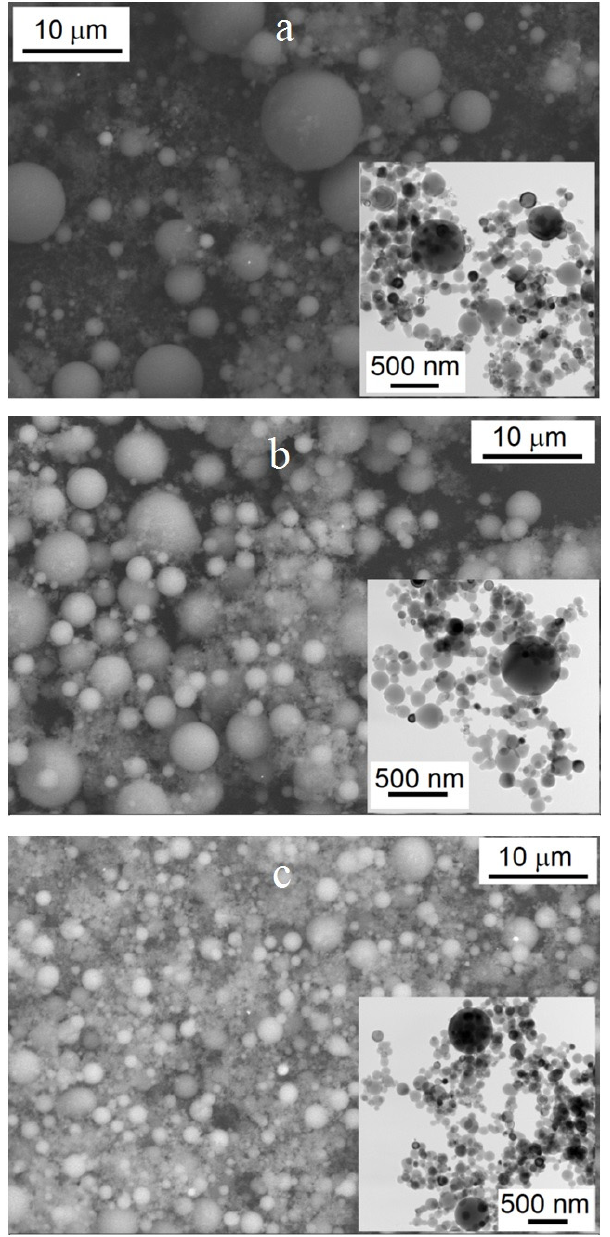
Figure 4. SEM images of aluminum particles. Inset shows TEM images of aluminum nanoparticles and submicroparticles: ( a ) Sample 1, ( b ) Sample 2, ( c ) Sample 3. With an increase in energy input to E/Es = 0.63 (Sample 2), the proportion of submi- cron particles and the number of particles with a size from 5 μ m to 8 μ m increased, while the proportion of particles with a size of more than 10 μ m decreased (Figures 4b and 5c). An increase in energy input up to E/Es = 0.95 (Sample 3) led to a decrease in the average size of microparticles, while there were no particles larger than 10 microns (Figures 4c and 5e).